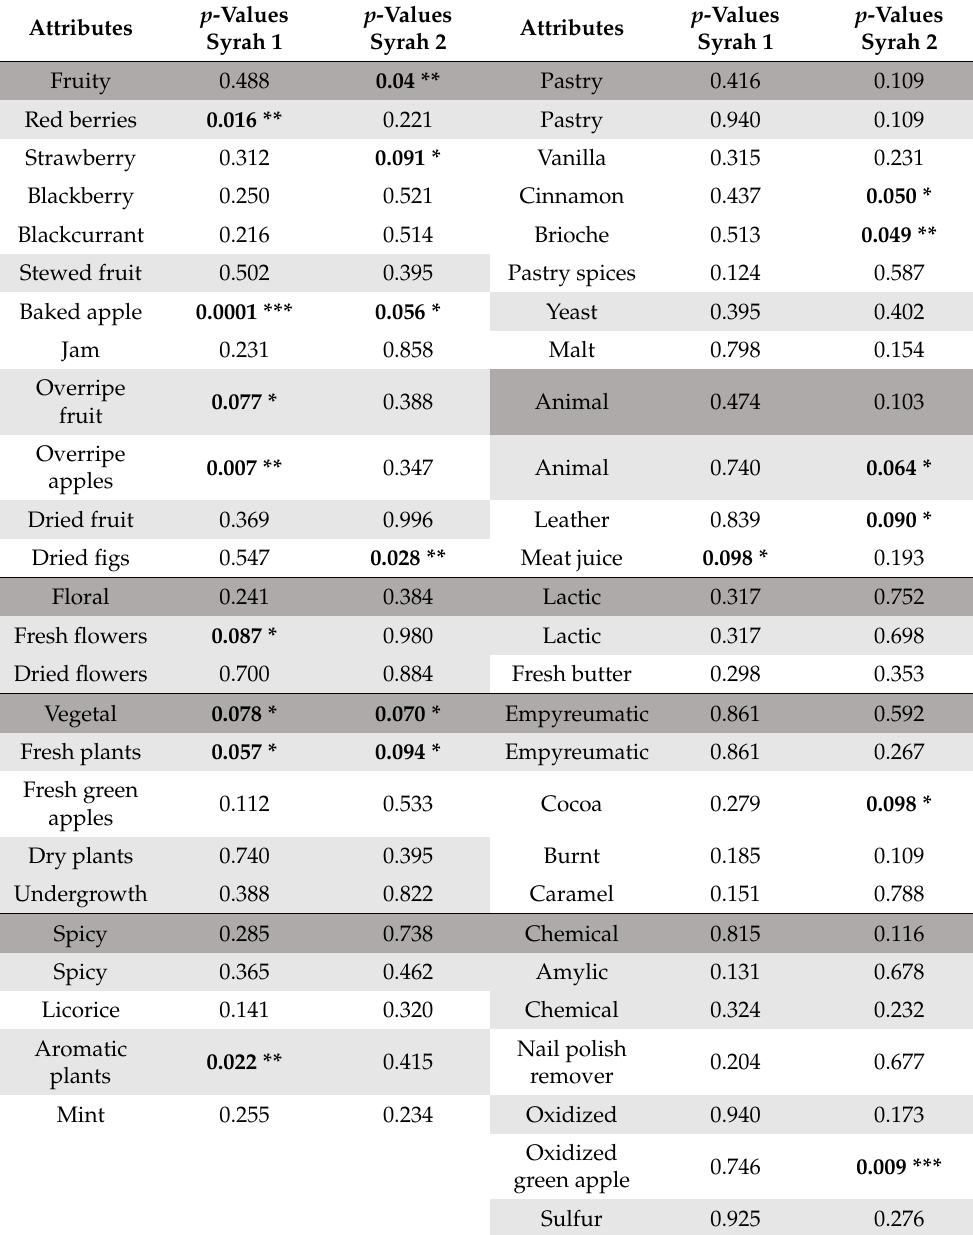
Table 5. Results of the Cochran’s Q test of each sample of Syrah red wine. *: Attribute whose citation frequency varies significantly between samples with α = 0.1; **: Attribute whose citation frequency varies significantly between samples with α = 0.05; ***: Attribute whose citation frequency varies significantly between samples with α = 0.01. Families – Sub-families –olfactory